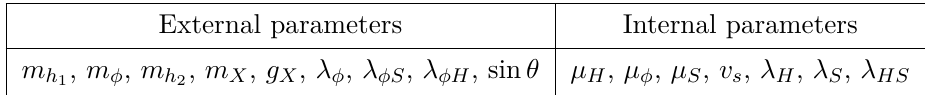
Table 4 . The parameters used in the aEWSB